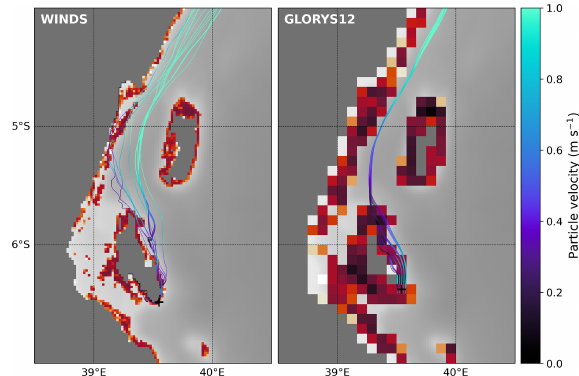
Figure 9. Coloured by instantaneous speed, 25 virtual drifter trajec- tories released from analogous coral reef cells at the southern tip of Zanzibar (Tanzania) on 1 July 2019 in WINDS-M (left) and GLO- RYS12V1 (right). Land cells for both models are shaded in dark grey. Red cells are coral reefs (Li et al., 2020), aggregated to the respective model grid, and shaded by total area per cell (shown for illustrative purposes